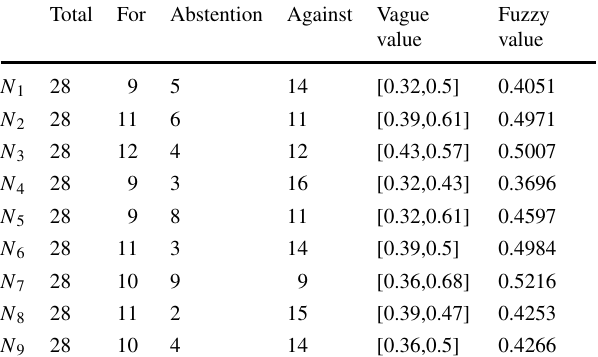
Table 12 Voting results for the nine nodes based on the vague set Total For Abstention Against Vague